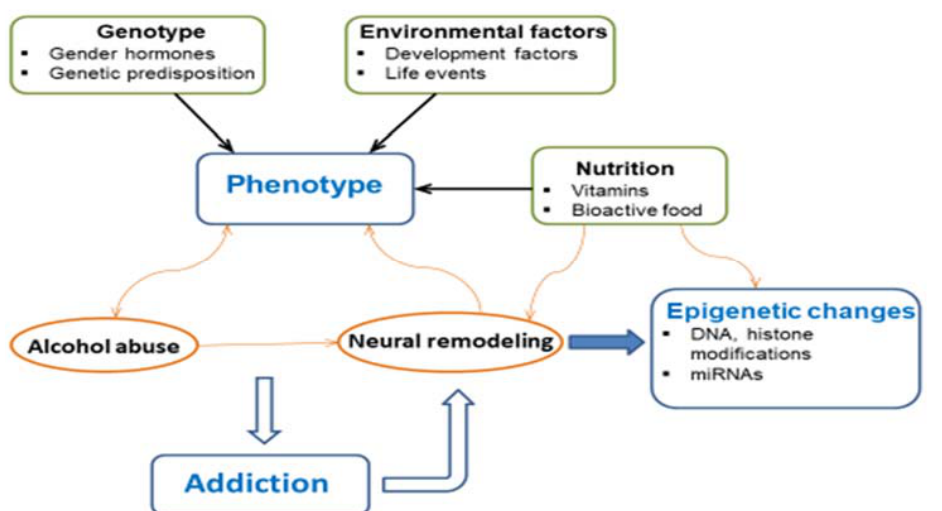
Figure 1. Mutual associations among nutrition, genetic background with epigenetic changes, and environmental factors forming the basis of addiction (Modified from Beayno, et al. [2]). The expression of a phenotype, both on a cellular and organismal level, is not only dependent on the hereditary luggage but may be also modulated by nutritional and environmental factors. This is the interplay of nonmodifiable variables describing the genotype and modifiable variables describing nutritional and environmental factors. Alcohol abuse modifies the structure of chromatin and modulates gene expression through epigenetic changes. In a feedback loop, this neural remodeling conversely re- inforces the abuse of alcohol. This is hypothesized to move alcohol abuse through the stages that eventually lead to